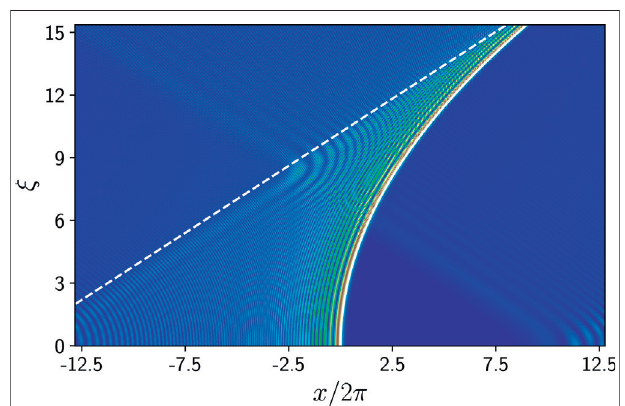
FIGURE 1 | Density plot of the normalized beam intensity of the incomplete Airy beam, Ai s (cid:2) 10 ( x , ξ ). The white dashed line is the de fi ning line x (cid:2) S ξ − S 2 , separating Airy-like and non – Airy-like regions. The beam retains Airy features to the right of the line. The white solid line is the main lobe parabola, x (cid:2) ξ 2 /4.